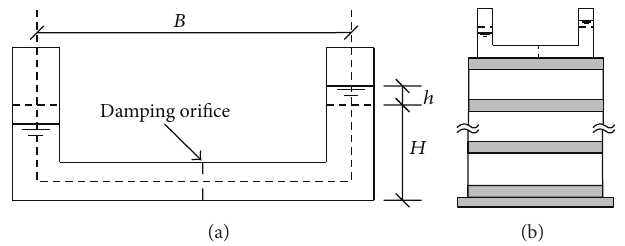
Figure 4: Tuned liquid column damper system: (a) tuned liquid column damper; (b) the building with tuned liquid column damper.